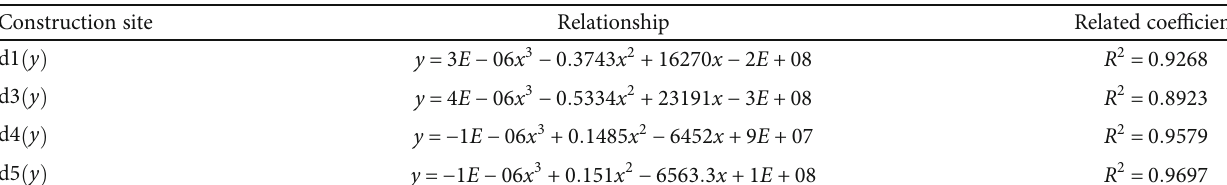
Figure 13: Monitored mining stresses of the vertical roadway. Table 6: The linear relationship of mining stress variation with time.